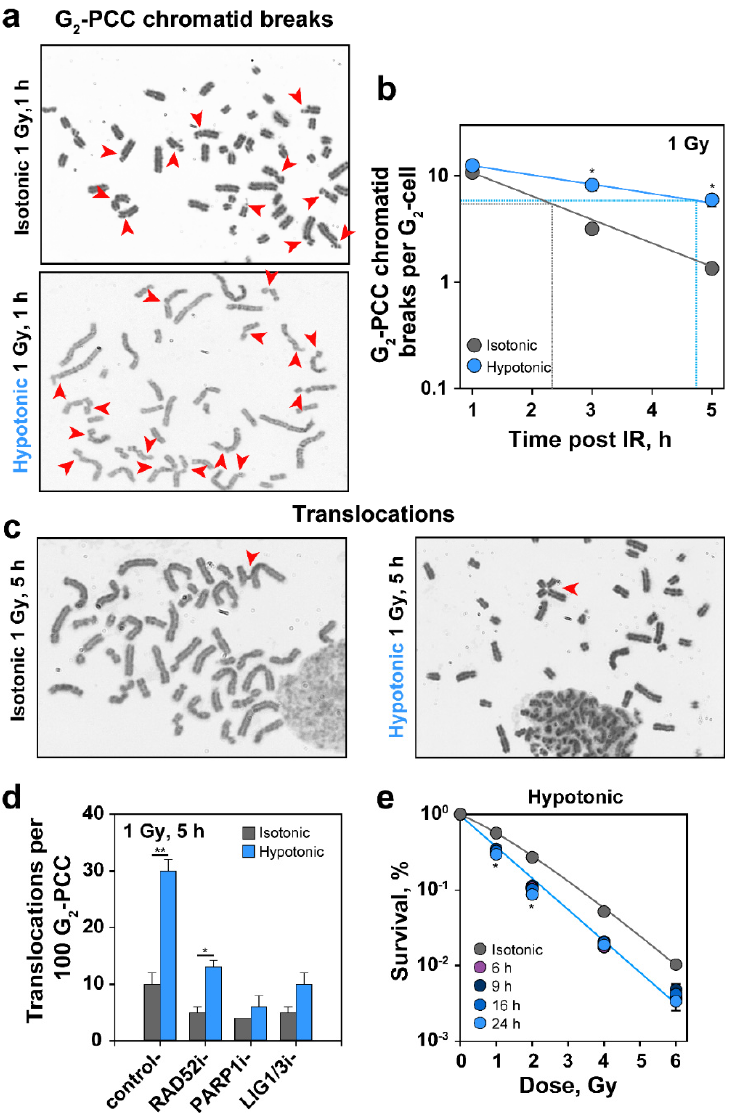
Figure 7. HypoS suppresses repair of interphase chromosome breaks, increases translocation formation and sensitizes cells to IR-induced killing. ( a ) RPE cells were incubated in isotonic or hypotonic medium after IR. G 2 -PCCs showing chromatid breaks (indicated by arrows) at 1 h after exposure to 1 Gy. ( b ) Kinetics of PCC break repair in cells exposed to 1 Gy and treated isotonically or hypotonically. Dotted lines indicate 50% chromatid break rejoining. Means ± SE are calculated from two experiments. Error bars are visible when larger than the symbols used. ( c ) Translocation formation in RPE cells exposed to 1 Gy and treated isotonically or hypotonically before processing for PCC. G 2 -PCCs at 5 h after exposure to 1 Gy showing translocations (indicated by arrows). ( d ) Quantification of translocations in cells treated with DMSO (control), RAD52 inhibitor (6-OH- DOPA, 10 µM), PARP1 inhibitor (PJ34, 5 µM), Ligase 1 and 3 inhibitor (L67, 50 µM), at 5 h after exposure to 1 Gy. Means ± SE are calculated from two independent experiments. ( e ) Clonogenic survival of isotonically and hypotonically treated RPE cells. Incubation in hypotonic medium after IR was carried out for 6, 9, 16 and 24 h (visible when the symbols are not overlapping). Means and SE are calculated from four determinations in two experiments. Error bars are visible when larger than the symbols used. For all plots, the significance of differences between individual measurements under isotonic and hypotonic conditions is indicated by the asterisk: * p < 0.05 and ** p < 0.01 (in e only if valid for all time points).